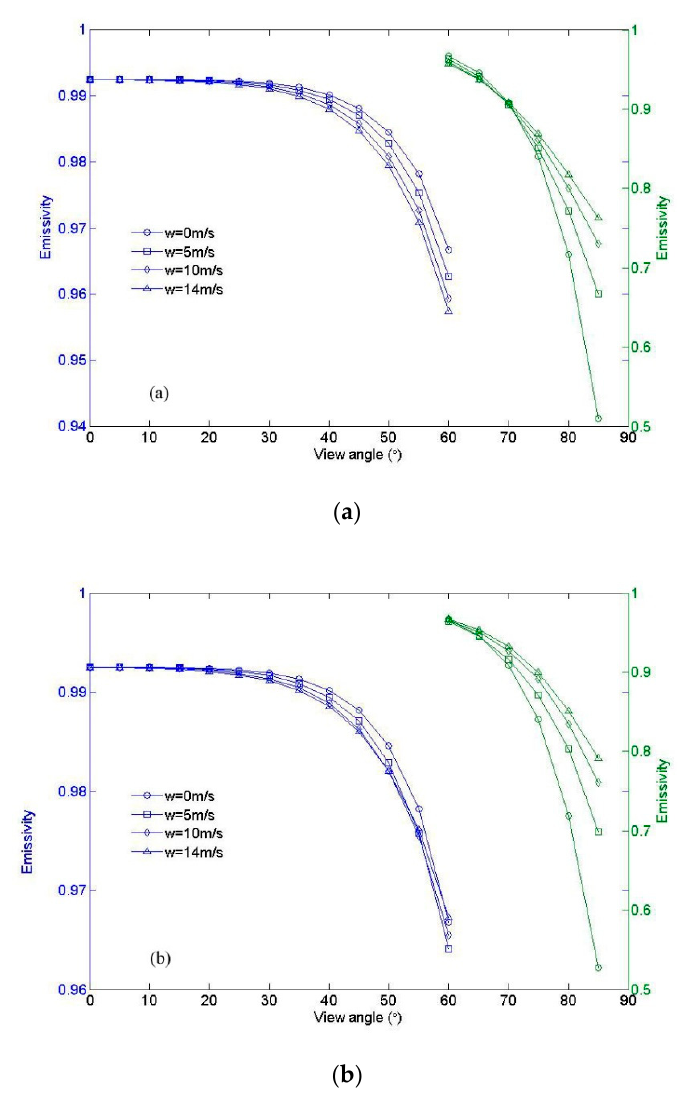
Figure 4. The results in ( a ) were calculated with a single interaction and do not include the reflected component, only direct emission from surface roughness; in ( b ), there are no limits and therefore roughness, shadowing, and reflections are all included. In (a) and (b), the left y axis applies to 0°–60°, whereas the right y axis applies to angles larger than 60°.